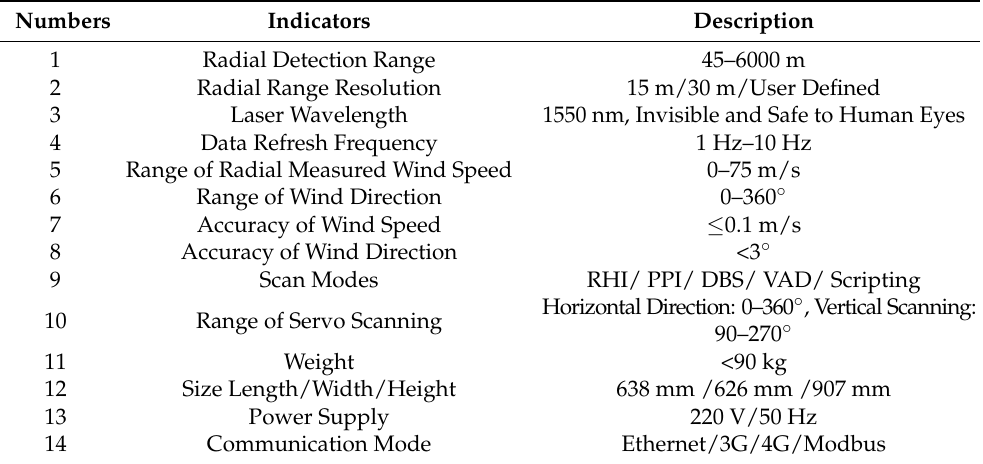
Table 1. Performance indicators of the lidar.